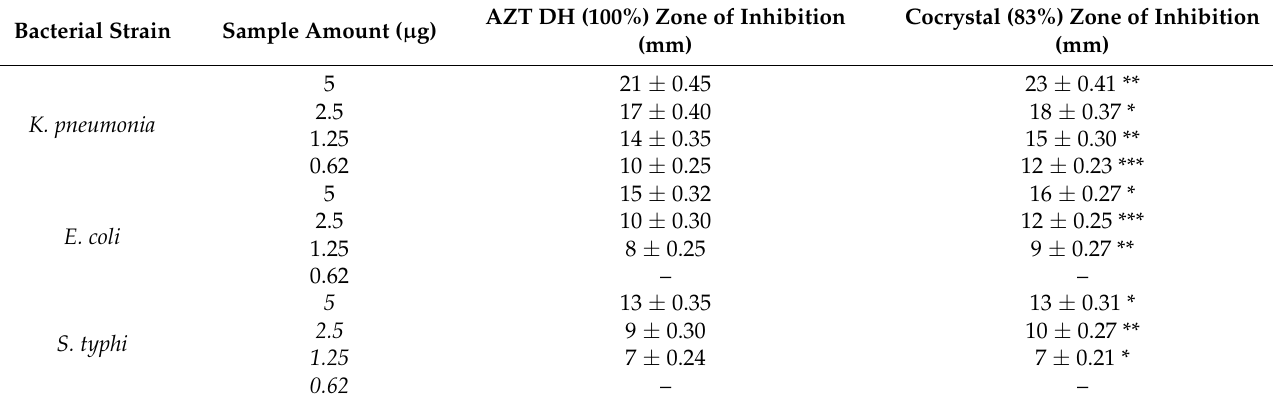
Table 2. Antimicrobial activity of AZT DH and cocrystal against different bacterial strains. Bacterial Strain Sample Amount ( µ g)